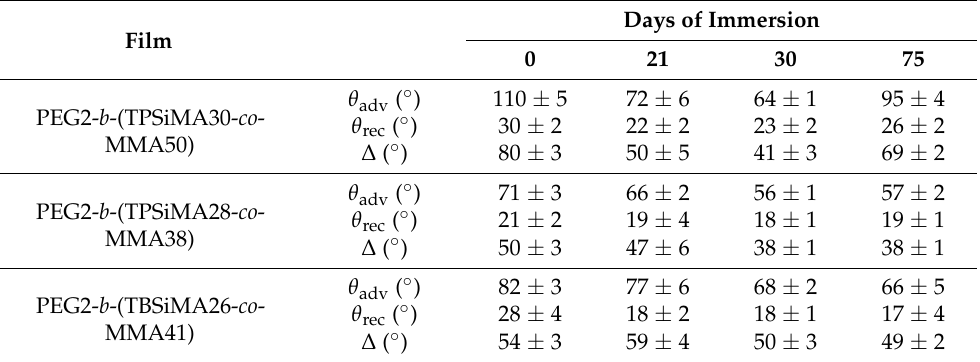
Table 2. Values of advancing ( θ adv ) , receding ( θ rec ) and hysteresis ( ∆ ) for selected PEGz- b -(TRSiMAx- co -MMAy) copolymers as a function of immersion in artificial